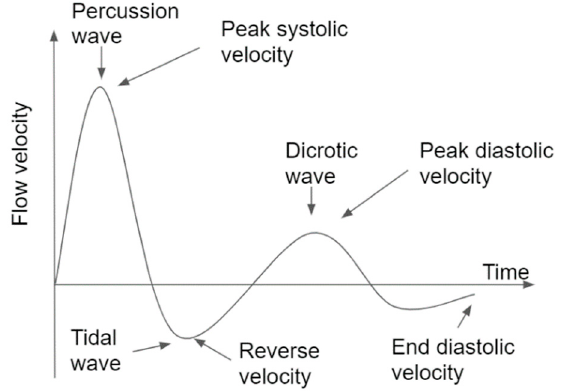
Figure 2. Typical waveform of wrist pulse signal.